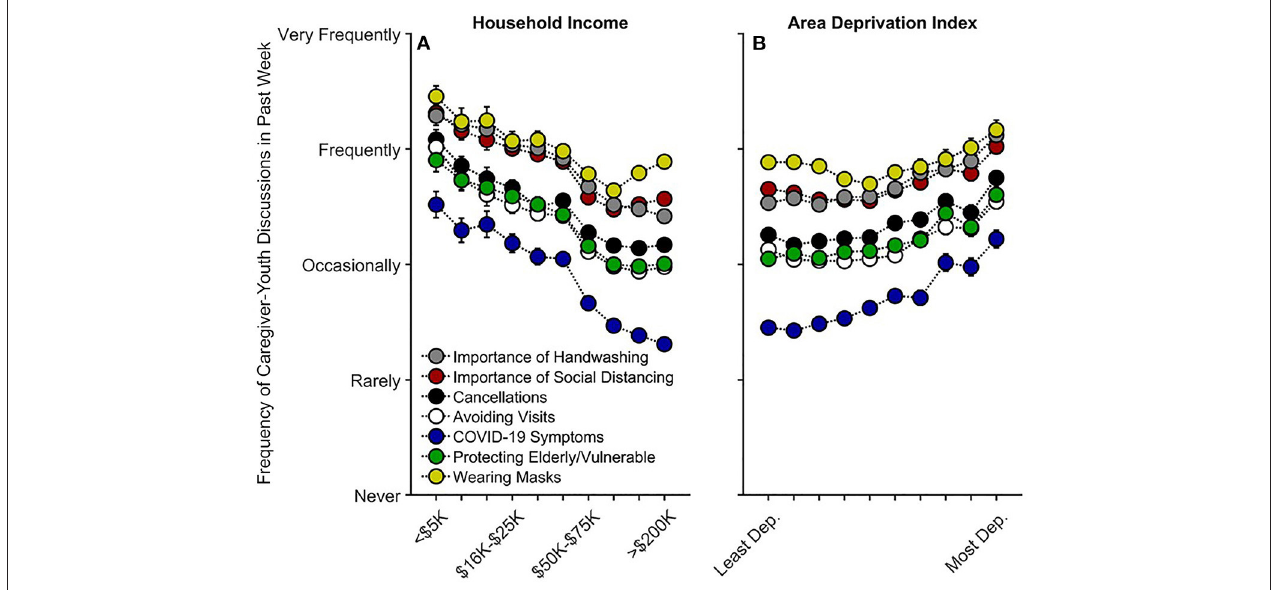
FIGURE 4 | Caregiver participants’ communication frequency with youth on factors related to COVID-19 risk and prevention as functions of (A) annual household income and (B) their home census tract’s area deprivation index. Error bars are ± 1 between-subjects standard error of the means. Analyses controlled for caregiver education, caregiver race, caregiver ethnicity, child sex, child age, questionnaire number, participants’ baseline study site, and participant, except for “Wearing Masks,” the analysis for which did not include questionnaire number or participant ID due to its only having one timepoint. Area deprivation index was collapsed across continuous deciles for graphing. Dep.,